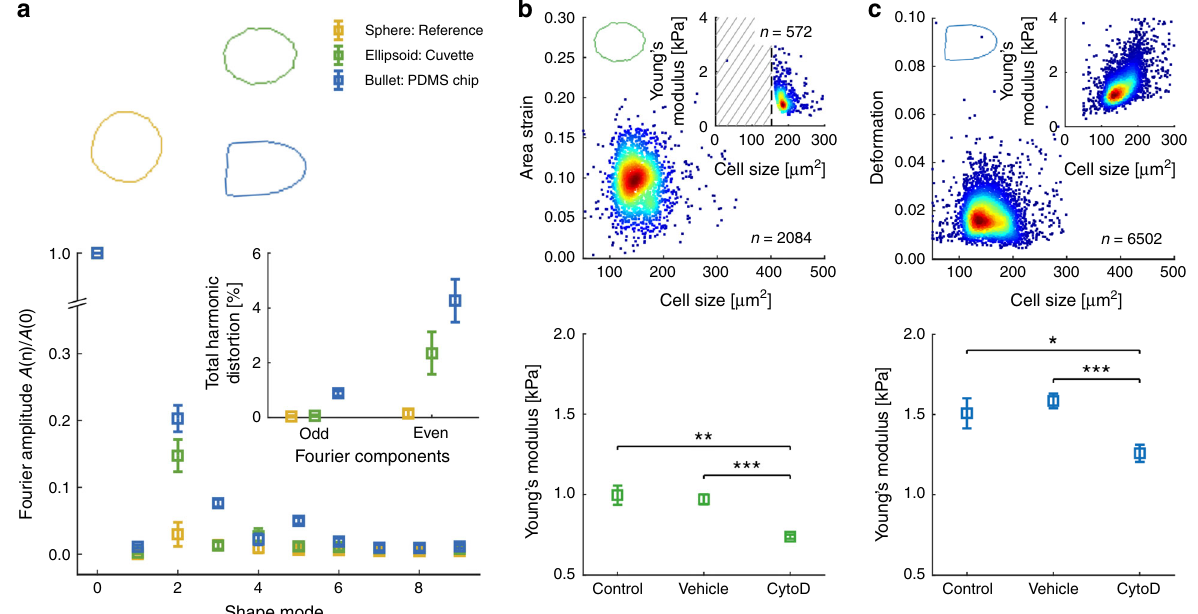
Fig. 5 High-throughput cell mechanics inside a fl ow cytometer glass cuvette. a Fourier amplitudes of cellular shape modes for n = 25 HL60 cells inside a w = 88 µ m (yellow) and w = 14 µ m (green) virtual channel of a glass cuvette as well as n = 25 HL60 cells inside the virtual channel of PDMS chip shown in Fig. 2 (blue). The inset represents the total harmonic distortion calculated for the cells inside the virtual channel of a cuvette (green), a PDMS chip (blue) and a reference measurement (yellow). Data are presented as mean ± standard deviation. b Area strain of HL60 cells inside a w = 14 µ m virtual channel of a glass cuvette ( Q sa = 15 nl s − 1 and Q sh = 1000 nl s − 1 , top). Inset shows Young ’ s modulus distribution of HL60 cells calculated from area strain with σ 78 Pa, shaded area indicates fraction of cells not con fi ned by the virtual channel. Bottom graph compares the Young ’ s modulus of three independent biological replicates of HL60 cells ( n = 2689), a DMSO vehicle control (0.25% (v/v); n = 3829), and HL60 cells treated with 1 µ M CytoD ( n = 3497). c Deformation of HL60 cells inside a w = 20 µ m virtual channel of a glass cuvette ( Q sa = 20 nl s − 1 and Q sh = 1000 nl s − 1 , top). Inset shows Young ’ s modulus distribution of HL60 cells calculated from a hydrodynamic model considering shear- and normal stress on cell surface in steady-state. Bottom graph compares Young ’ s modulus of three independent biological replicates of HL60 cells ( n = 19,018), a DMSO vehicle control (0.25% (v/v); n = 23,612) and HL60 cells treated with 1 µ M CytoD ( n = 15,245). Scale bar is 20 µ m. Color in scatter plots indicates a linear density scale from min (blue) to max (red). Statistical data analysis is performed using linear mixed models and data are presented as mean ± standard error of the mean (* p < 0.05; ** p < 0.01; ** *p <